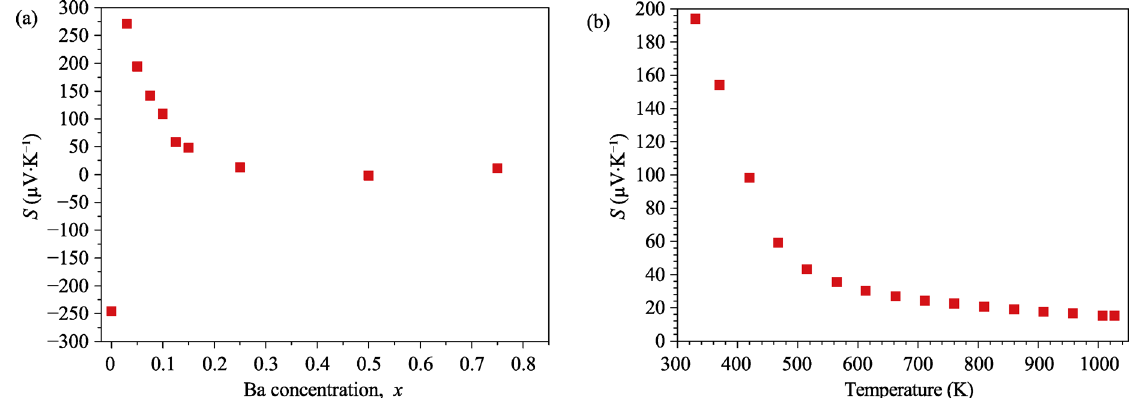
Fig. 5 S for La 1 − x Ba x CoO 3 (a) with 0 ≤ x ≤ 0.75 at 330 K and (b) with x = 0.05 at different temperatures.